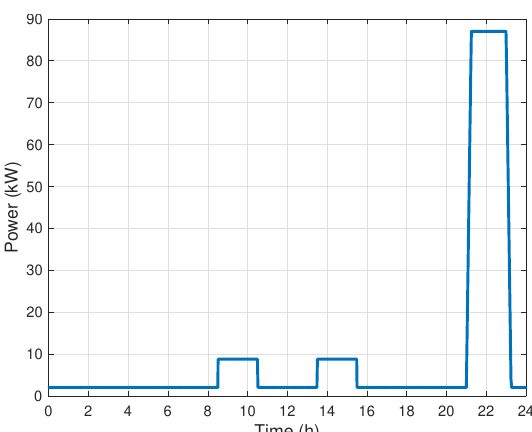
Figure A8. Kitchen shelter equipment power.